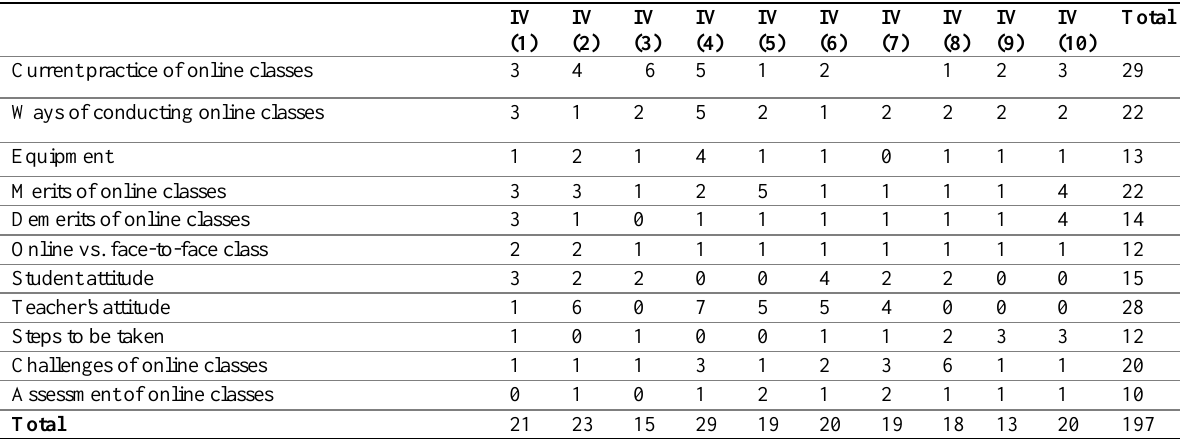
Table 6: Code-document Table for the Interviews